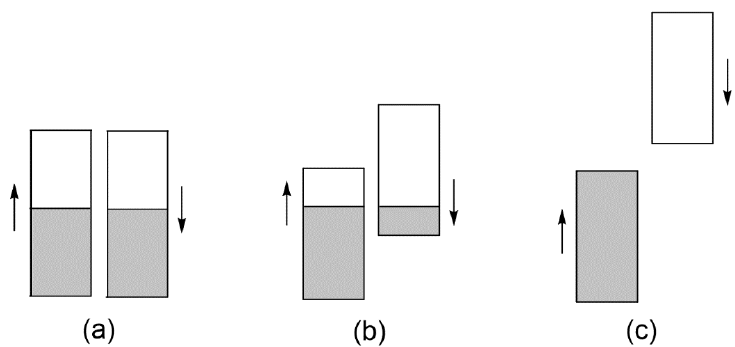
Figure 11. The description of a band in terms of up-spin and down-spin subbands: ( a ) When the up-spin and down-spin bands are not spin-polarized, leading to a nonmagnetic metallic state. ( b ) When the up-spin and down-spin bands are partially spin-polarized, leading to a magnetic metallic state. ( c ) When the up-spin and down-spin bands are completely spin-polarized, leading to a magnetic insulating state.